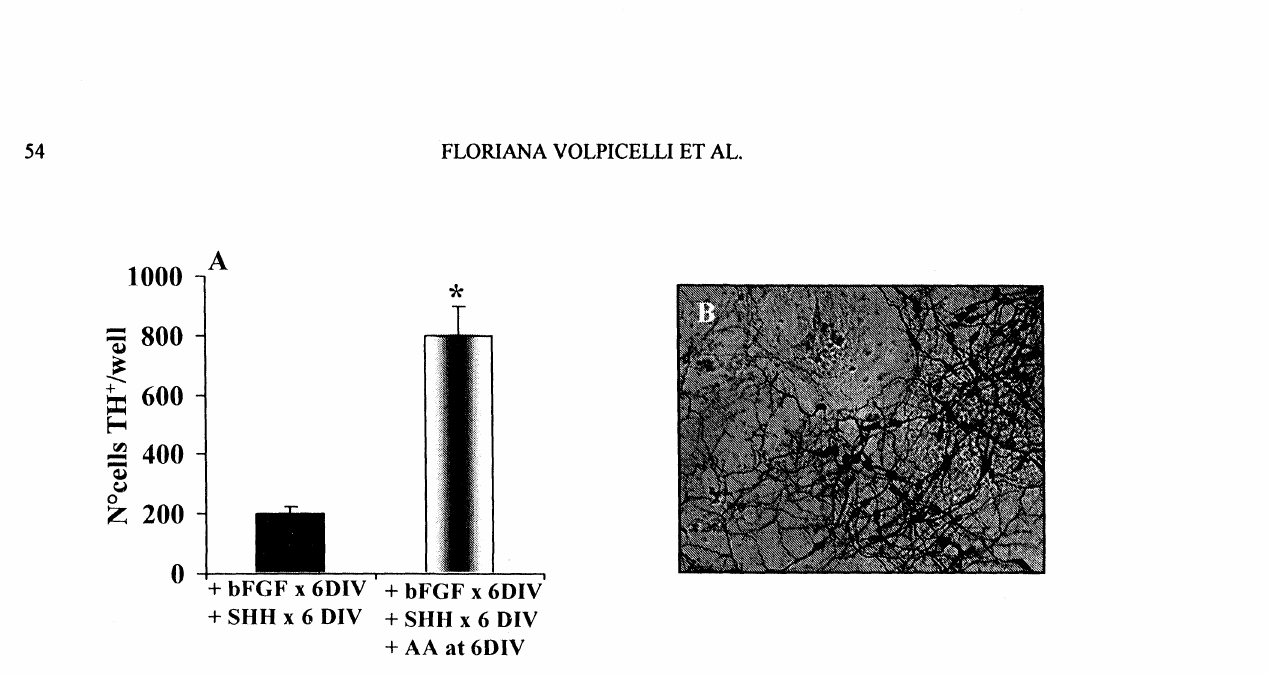
Fig. 5: The role ofascorbic acid. (A): Cells treated with 200 tM ascorbic acid (AA) at 6 DIV after the stimulation with bFGF and SHH for to 6 DIV. The bars represent the mean +/- SEM of triplicate samples for each experimental point. Asterisks represent p<0.01 when compared to cultures without AA (ANOVA, Schefti test). (B): TH-immunoreactive neurons at 9 DIV, after stimulation with bFGF and SHH for 6 DIV and subsequent addition of AA for 3 DIV.